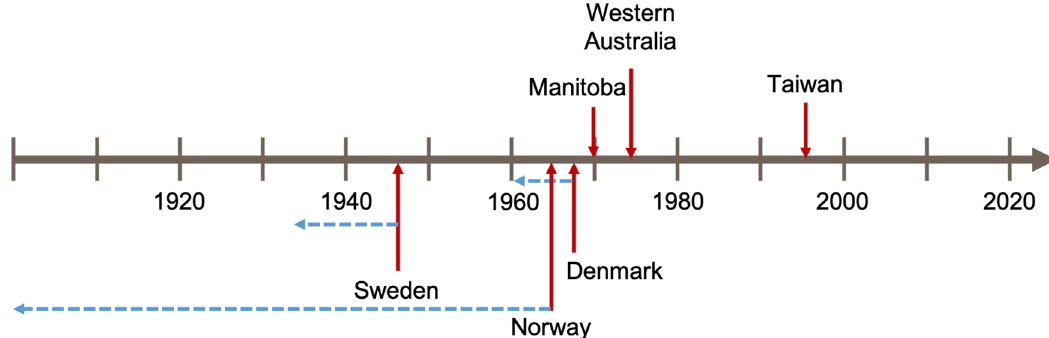
a Red arrows indicate start of data temporal coverage b Blue arrows indicate that the site reports having data coverage extending prior to the collection of familial